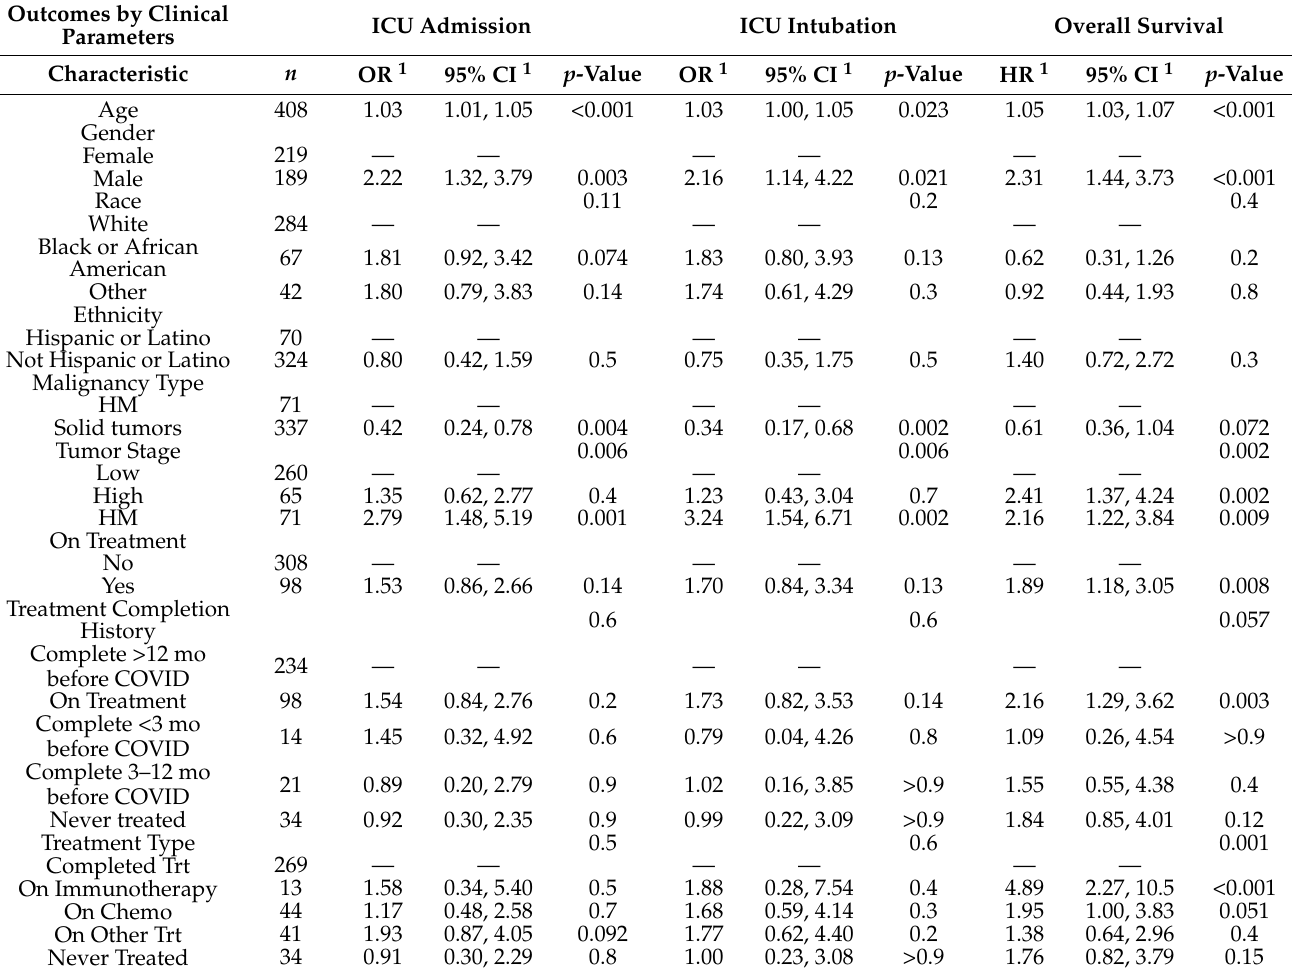
(Table 4). Association with ICU admission, ICU intubation, and overall survival was similar in multivariable regression models adjusted for age, race, and gender (Supplementary Table S3). Table 3. Clinical predictors of ICU admission, ICU intubation, and overall